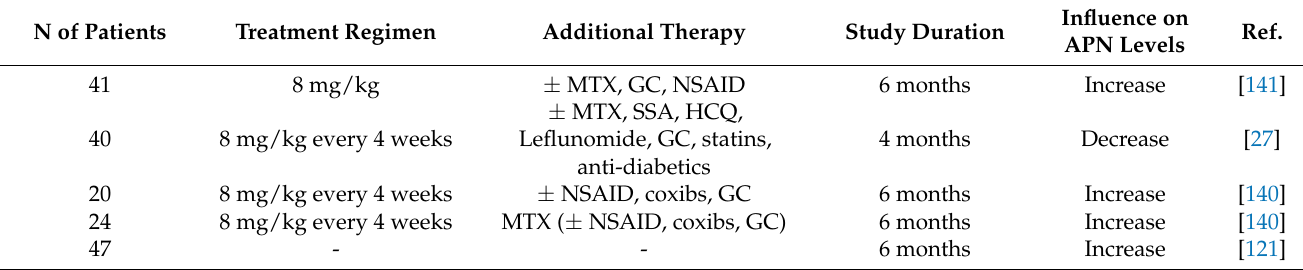
Table 4. Tocilizumab effects on circulating adiponectin levels in rheumatoid arthritis. N of Patients Treatment